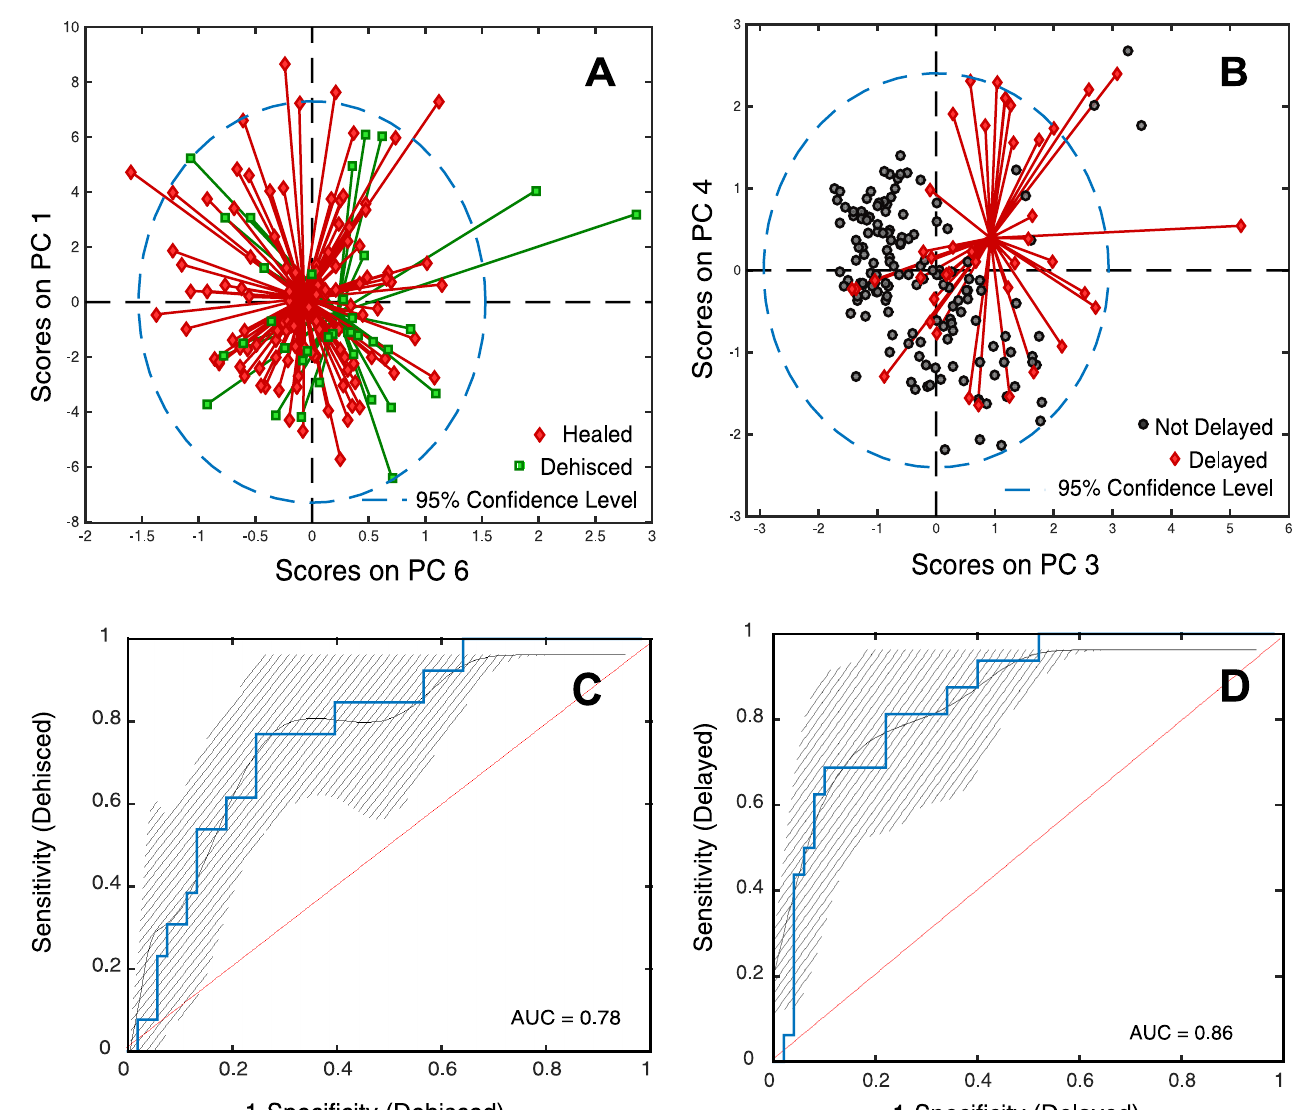
Fig 4. Comparison of principal component analysis (PCA) and partial least squares discriminant analysis (PLSDA). PCA score plots are shown for A) healed versus dehisced wounds, and B) delayed versus not-delayed wounds. There is significant overlap for healed and dehisced wounds while delayed and not- delayed wounds display some separation. Prediction ROCs derived from PLSDA models are exhibited with 95% confidence intervals in panels C&D (respectively) for: healed versus dehisced wounds, and delayed versus not-delayed wounds. The AUCs indicate improved separation of delayed and not-delayed wounds compared to healed and dehisced